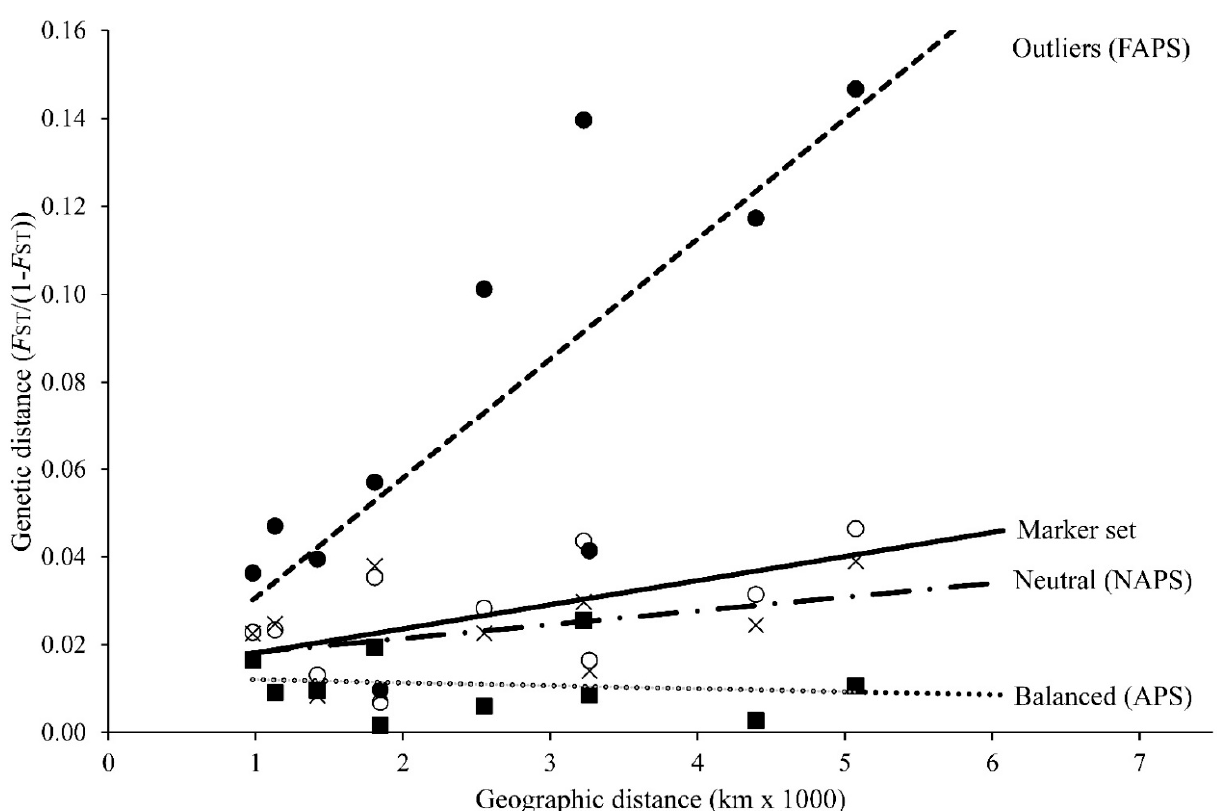
Figure 3. Pairwise test of isolation by distance among five regions of the European hake upon four marker types. Balanced: six balanced markers (closed squares and dotted line; Y = − 7 × 10 − 7 X + 0.0127; R 2 = 0.0163; p = 0.641); Neutral: 16 absolute neutral markers (crosses and dashed-dotted line; Y = 3 × 10 − 6 X + 0.0151; R 2 = 0.1685; p = 0.193); Full marker set: 26 microsatellites (open circles and continuous line; Y = 5 × 10 − 6 X + 0.0126; R 2 = 0.3565; p = 0.064); Outliers: 4 outlier markers (closed circles and dashed line; Y = 3 × 10 − 5 X + 0.0034; R 2 = 0.6218; p = 0.020).